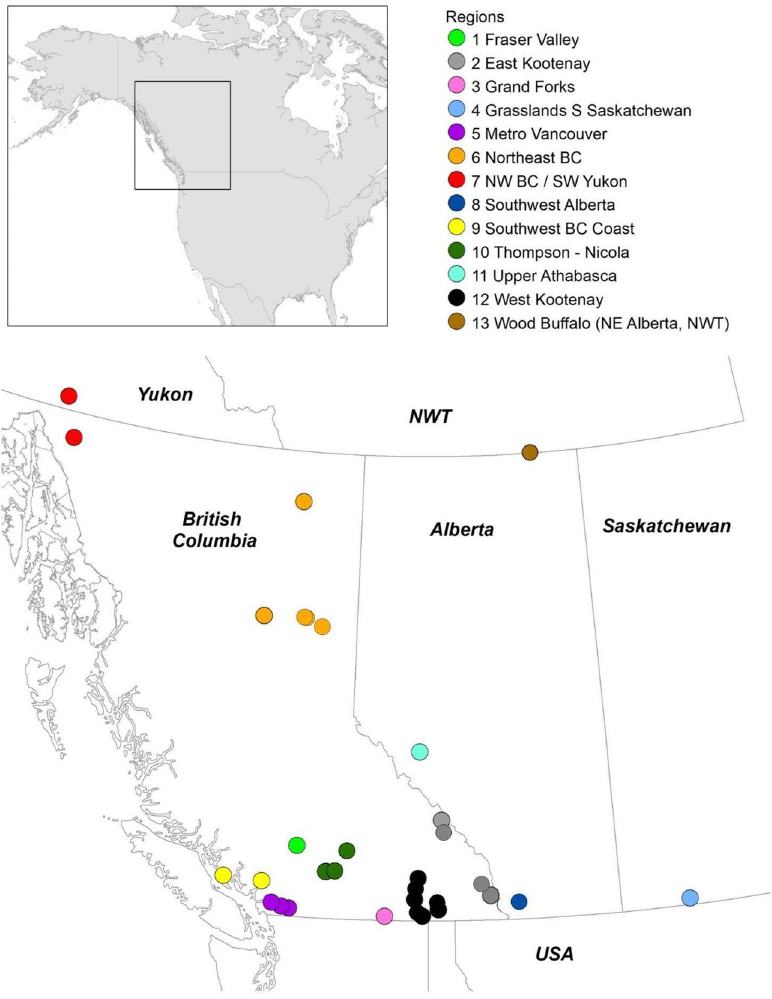
Figure 1. Map of the approximate sampling locations of bats surveyed in this study. Locations spanned three provinces and one territory in Western Canada. Broad geographic regions (13), based on landscape/land- use, are represented with colours (NWT = Northwest Territories). This map was made with Esri ArcMAP Geographic Information System (GIS) software version 10.8.1 and assembled using base map World Countries (Esri, Delorme Publishing Company, Inc).